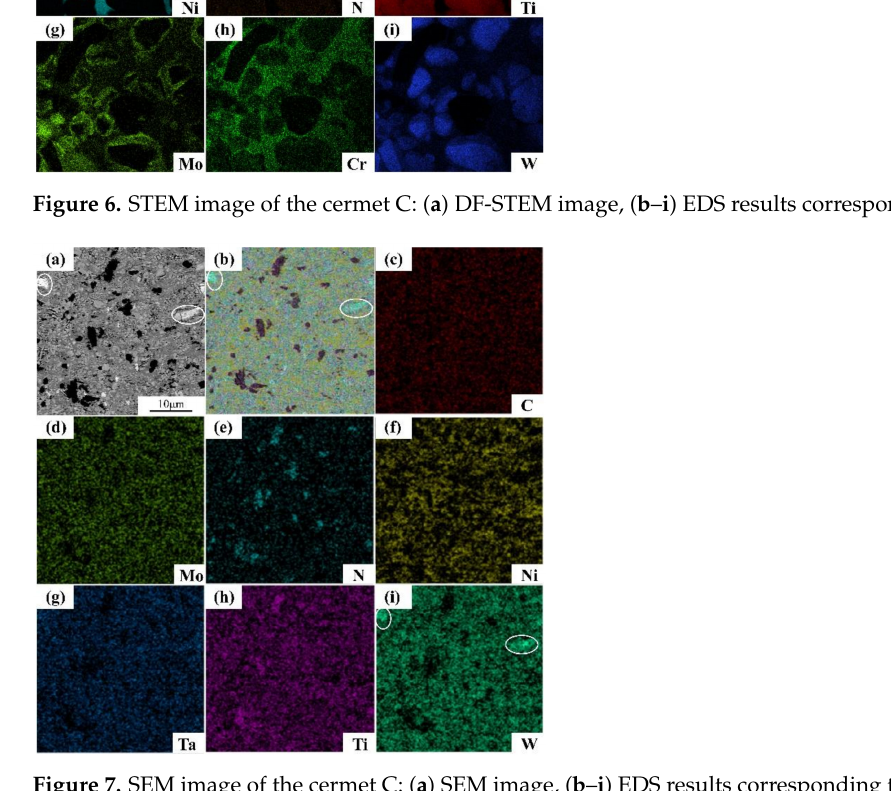
Figure 7. SEM image of the cermet C: ( a ) SEM image, ( b – i ) EDS results corresponding to ( a ).